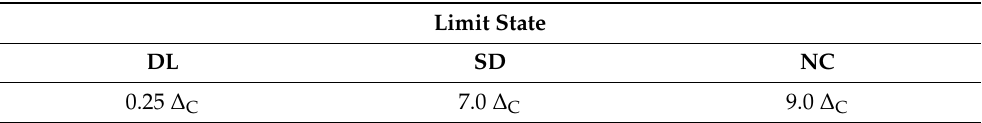
Table 2. Capacity in terms of axial deformation for braces in